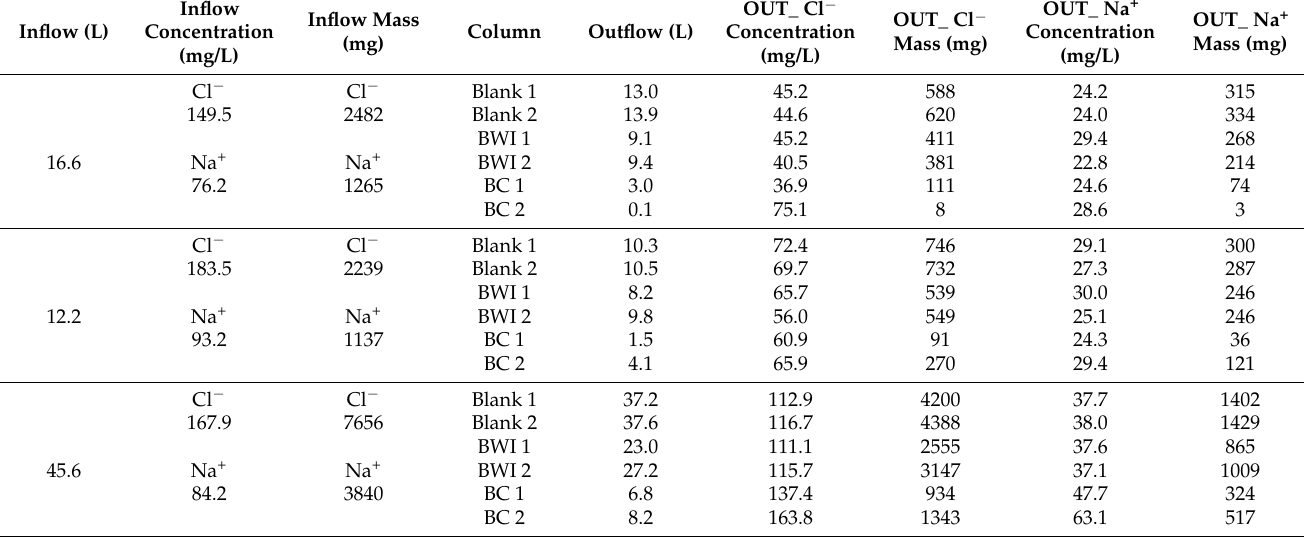
Table 5. Inflow and outflow water characteristics for medium-level deicing salt concentration of synthetic stormwater runoff (Blank: no plants; BWI: Blue Wild Indigo; BC: Broadleaf